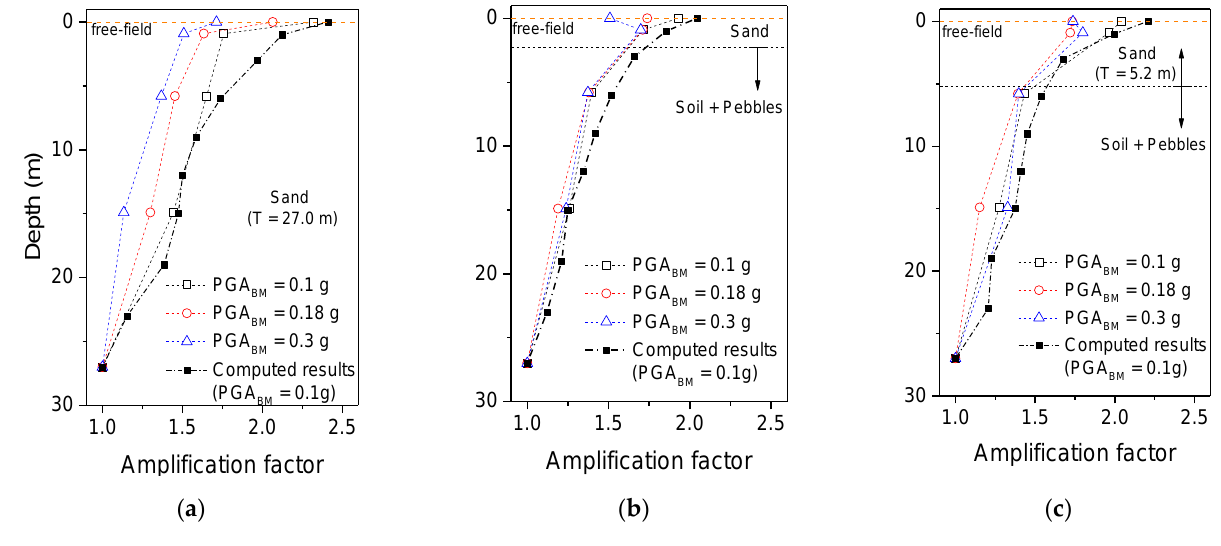
Figure 4. Amplification factor in the soil at ( a ) Uni, ( b ) L1, and ( c ) L2 profiles.